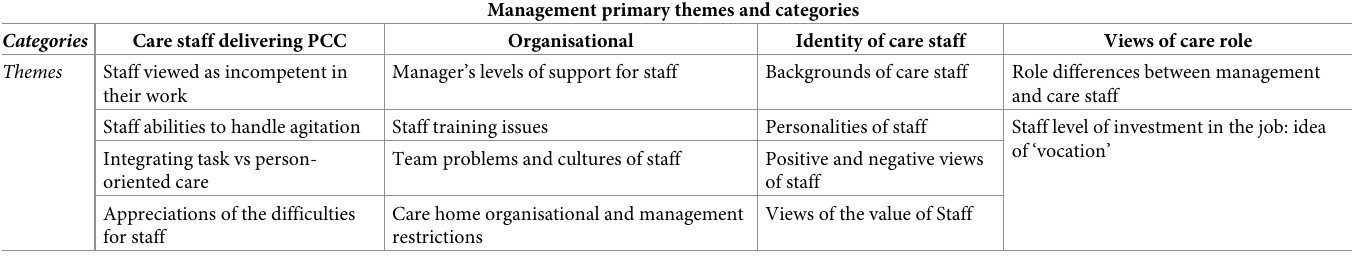
Table 2. Management primary themes and